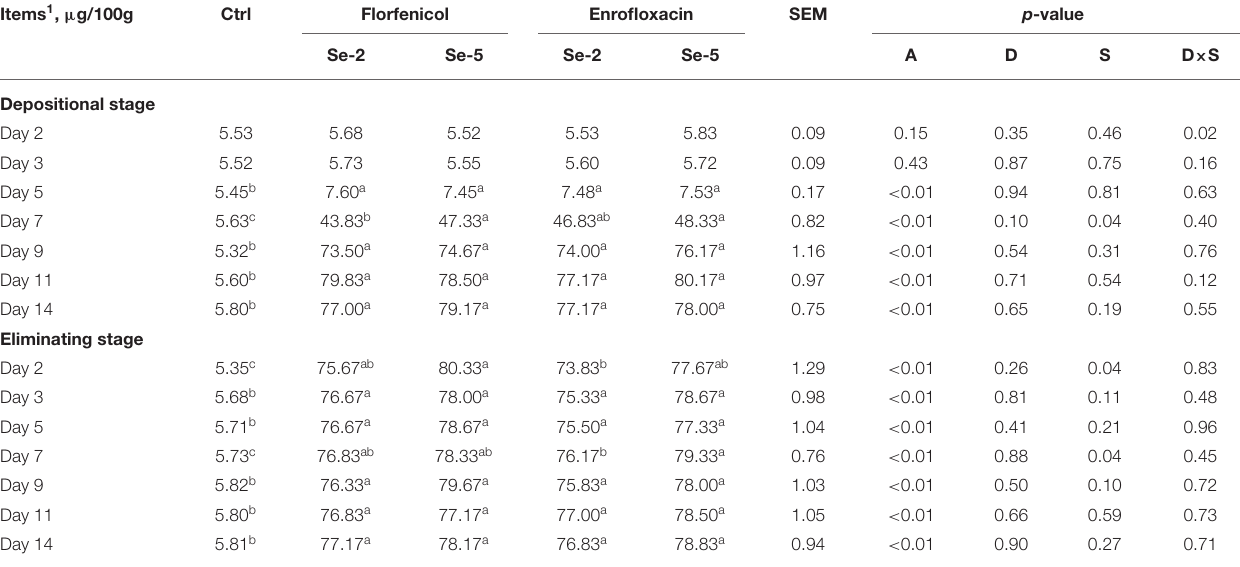
TABLE 10 | Effects of dietary organic selenium and drugs on the concentration of selenium in egg albumen of laying hens. Items 1 , µ g/100g Ctrl Florfenicol Enrofloxacin SEM p -value Se-2 Se-5 Se-2